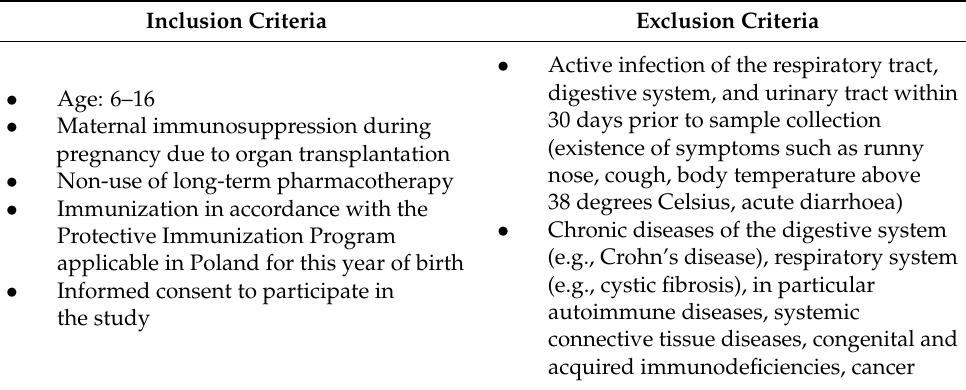
Table 1. Inclusion and exclusion